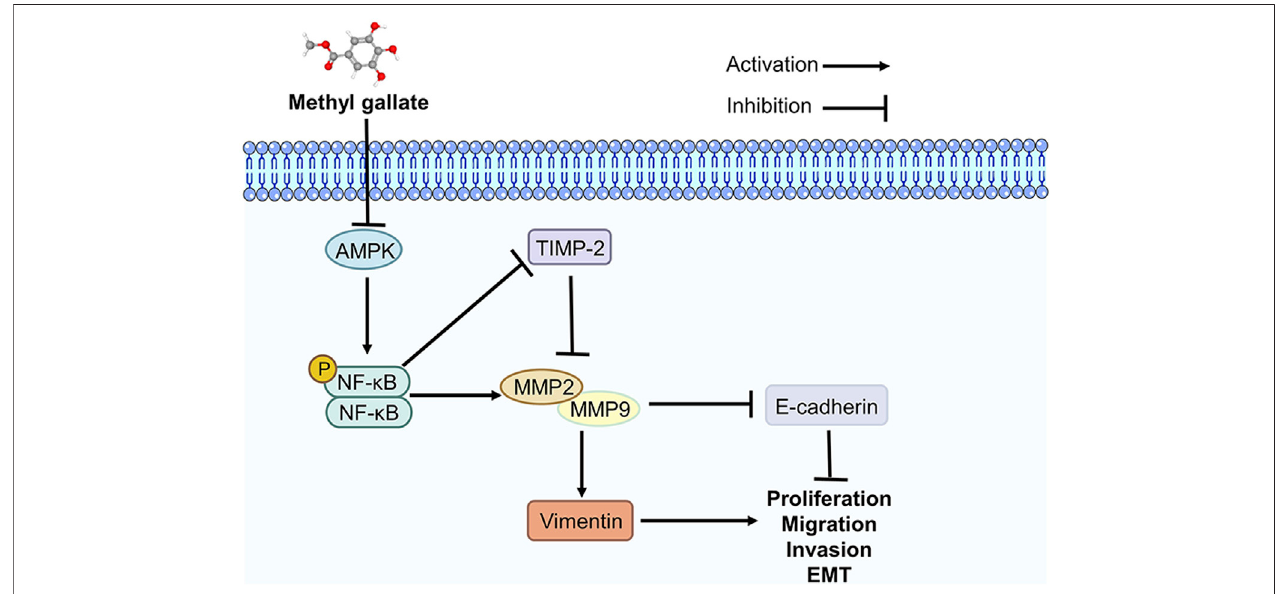
FIGURE 6 | Methyl gallate inhibits migration, invasion and epithelial-mesenchymal transition of hepatocellular carcinoma through AMPK/NF- κ B signaling pathway.